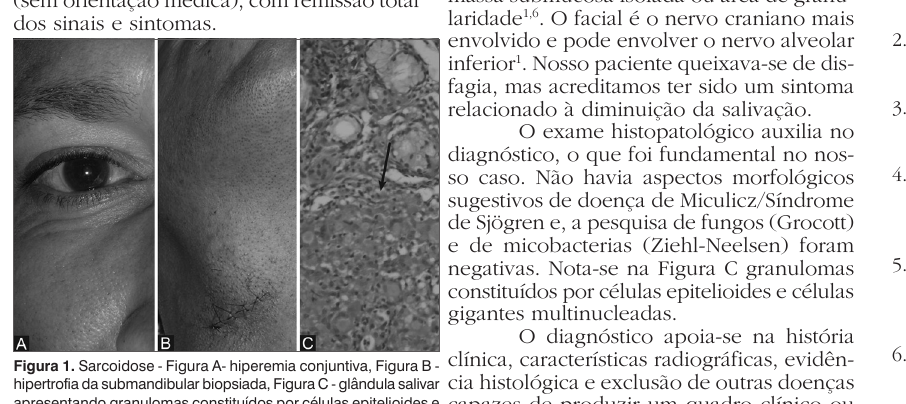
Figura 1. Sarcoidose - Figura A- hiperemia conjuntiva, Figura B - hipertrofia da submandibular biopsiada, Figura C - glândula